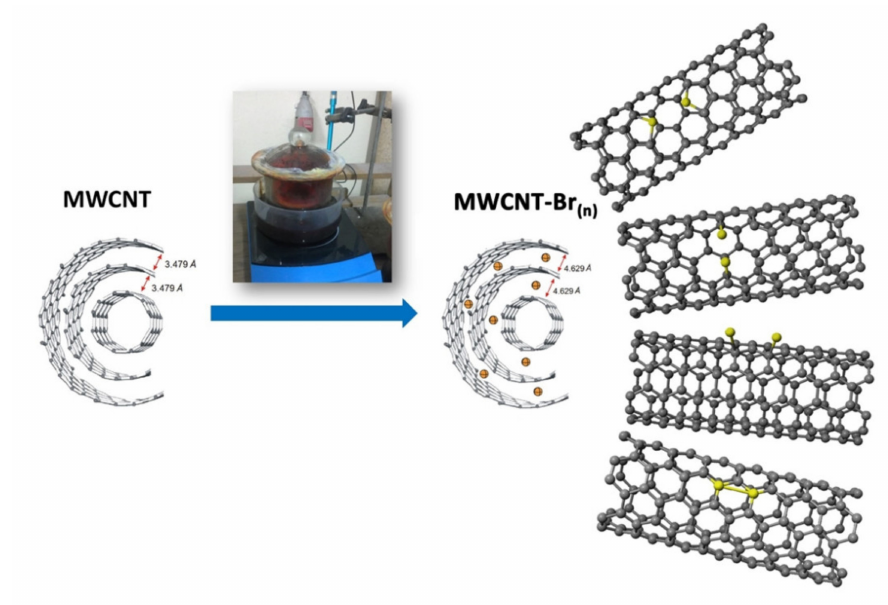
Figure 1. A schematic representation of the experimental